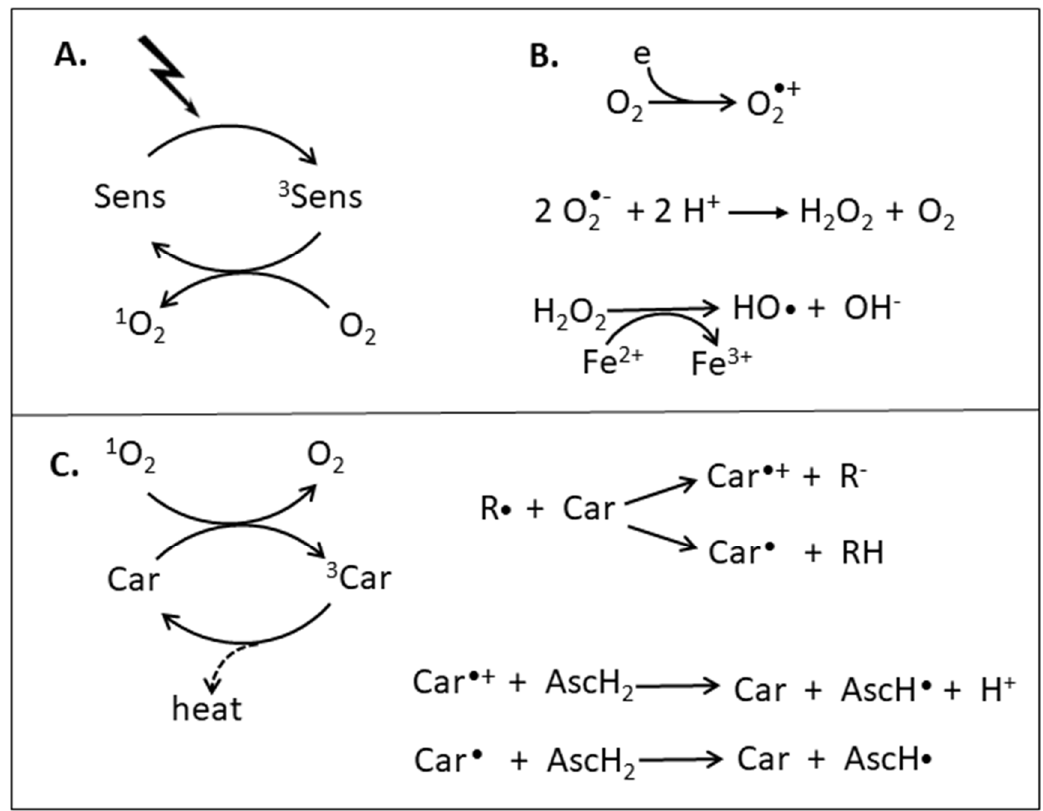
Figure 1. Formation of reactive oxygen species and their reaction with carotenoids. ( A) Photosensitized formation of singlet oxygen, ( B ) radical formation, ( C ) reactions of carotenoids with singlet oxygen or radicals and regeneration by ascorbate.